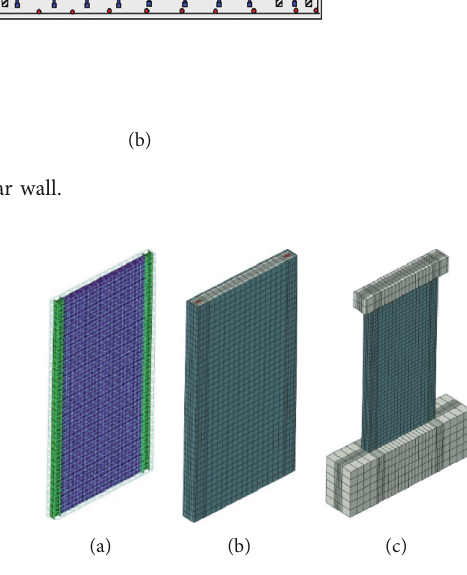
Figure 2: Modelling of the SPRC shear wall. (a) Structural steel, steel plate, and reinforcements. (b) Concrete. (c) The whole FE